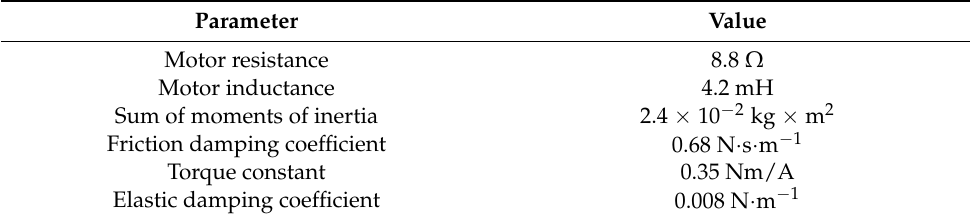
Table 2. The parameters of the moving mirror control